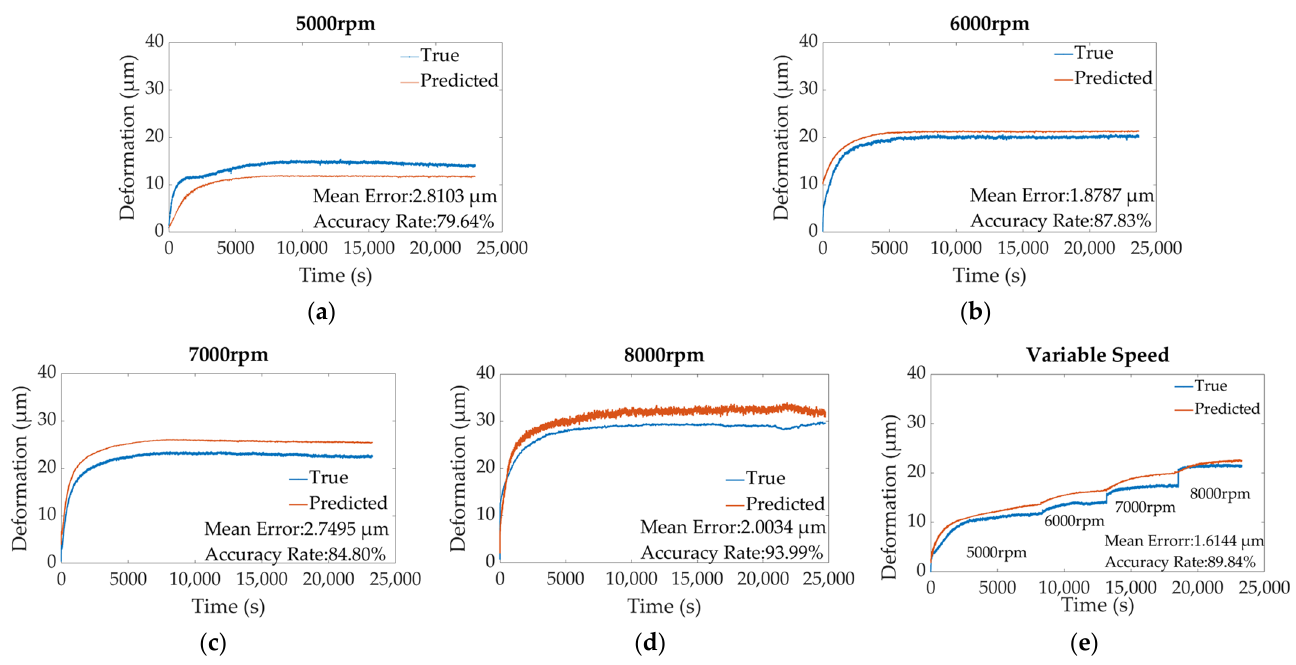
Figure 8. The external validation of the thermal error model trained by Gaussian process regression under the rotational speed of ( a ) 5000 rpm; ( b ) 6000 rpm; ( c ) 7000 rpm; ( d ) 8000 rpm; ( e ) variable speed.